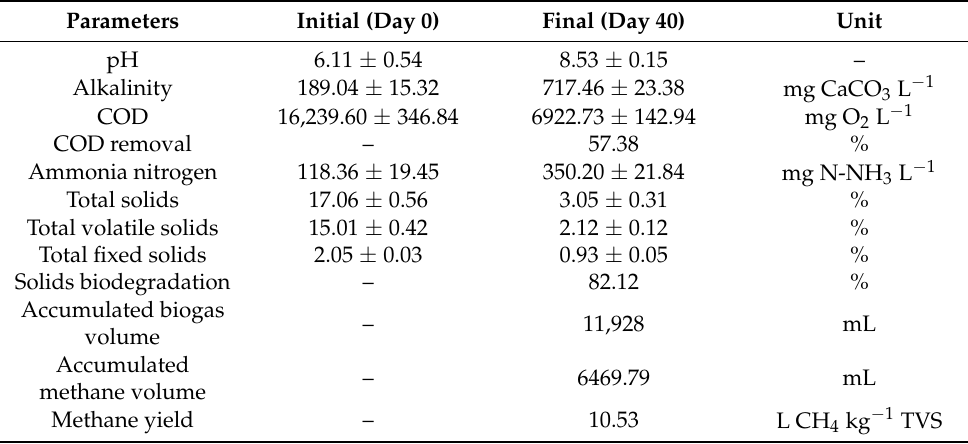
Table 2. General parameters recorded to the dry AD of